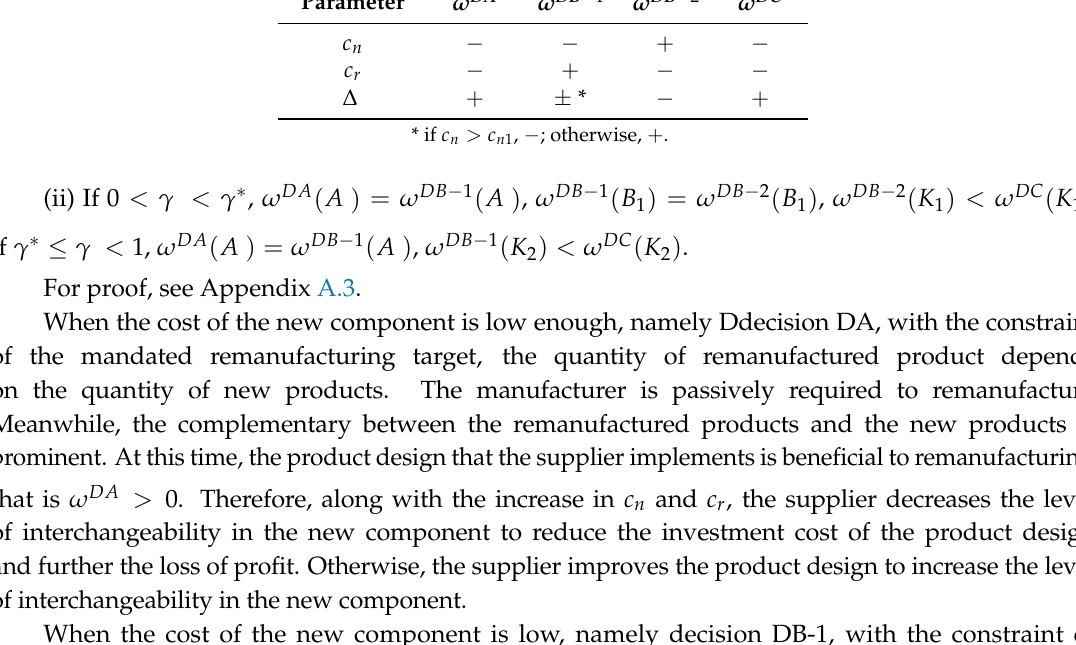
Table 4. The impacts of cost parameters on the supplier’s product design. Parameter ω